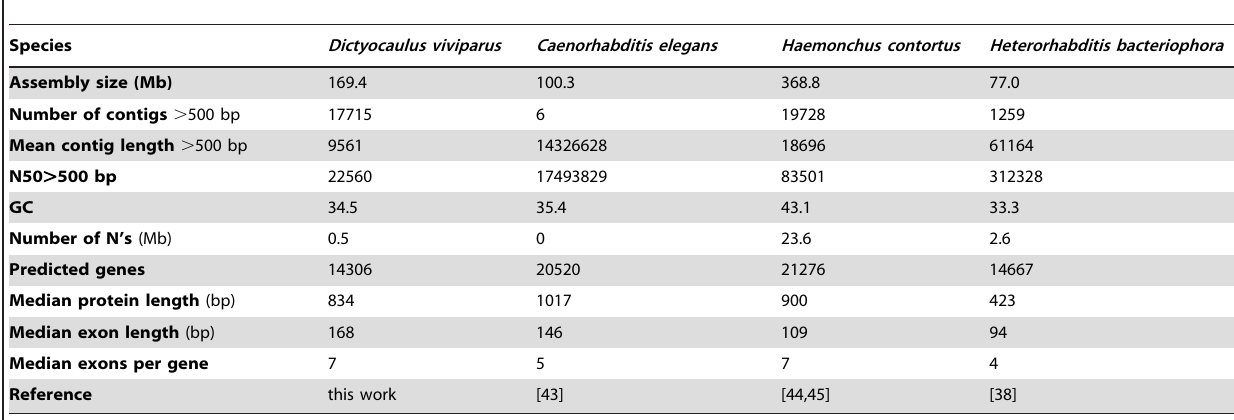
Table 2. Genome assembly and annotation metrics of D. viviparus and other Rhabditina species.